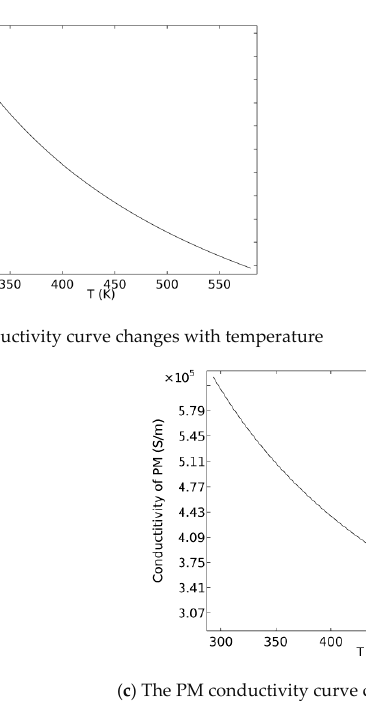
Figure 3. The conductivity curve changes with temperature.